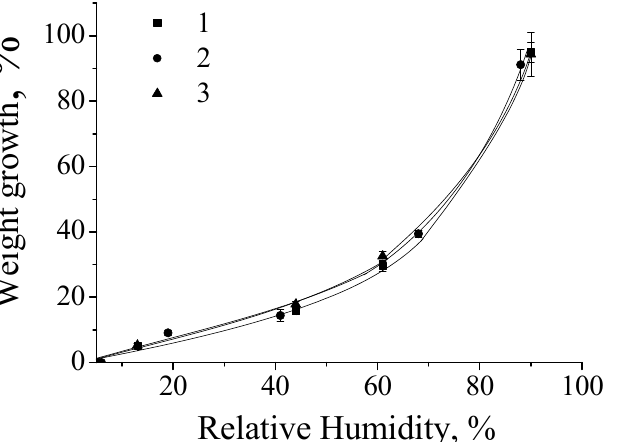
Figure 2. Dependence of the coating formed from PDADMAC 100 (1), PDADMAC 200 (2) and PDADMAC 400 (3) weight on the relative humidity.